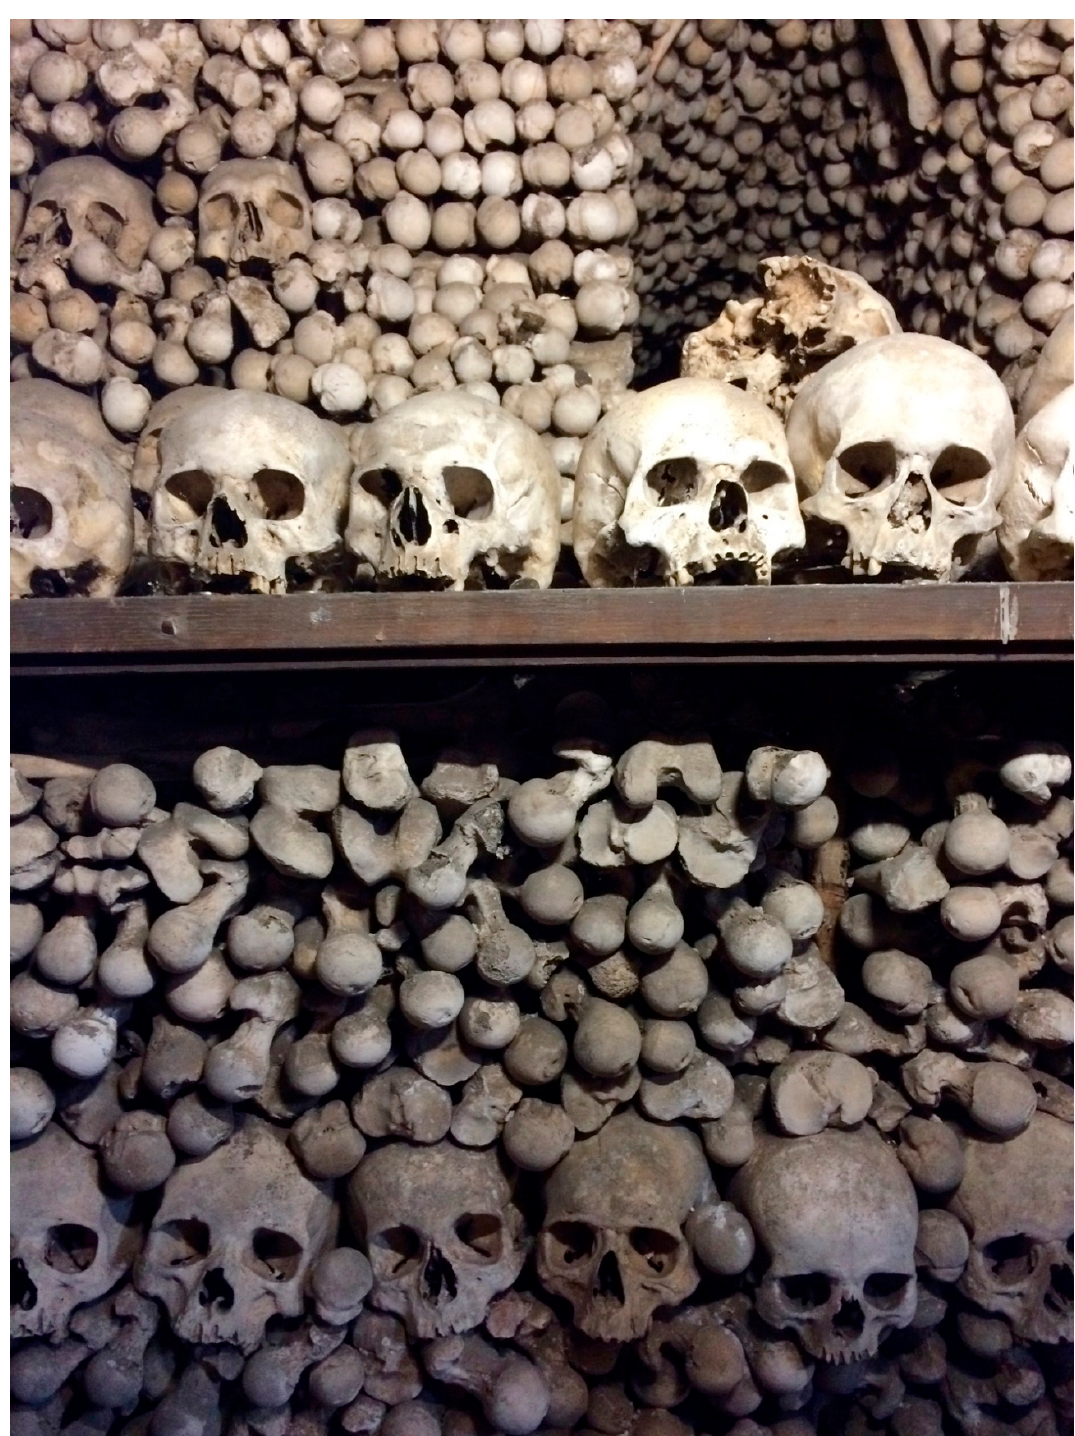
Figure 2. Sedlec Ossuary, stacks of bones (close up), interior, May 2016. Kelsey Perreault.